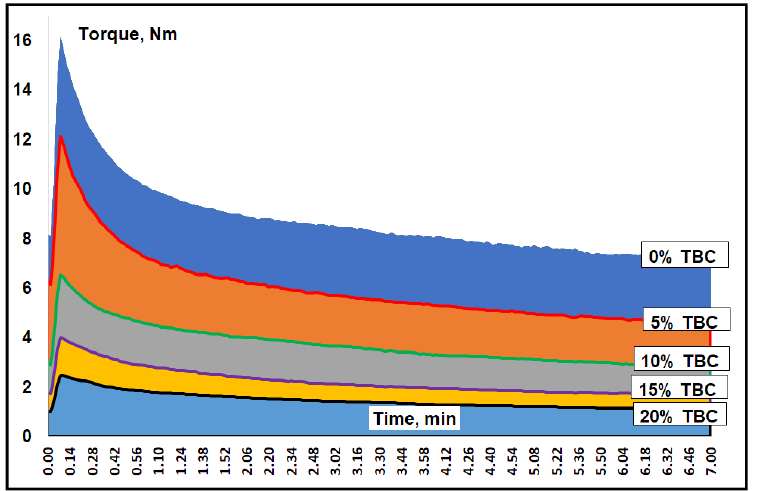
Figure 4. Evolution of torque during melt mixing of PLA–AII composites plasticized with different percentages of